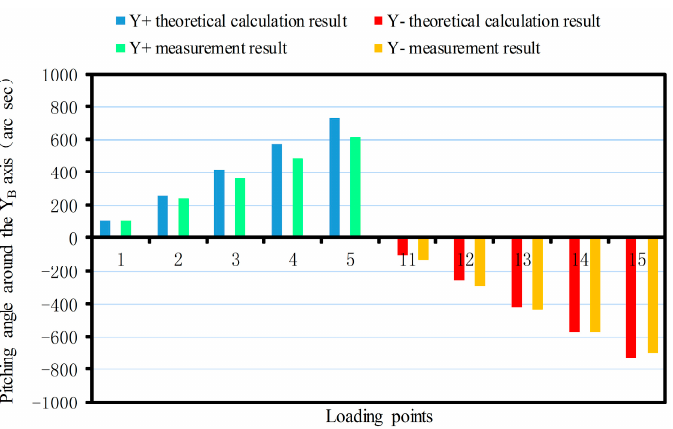
Figure 15. Pitching angle comparison around the X B -axis.